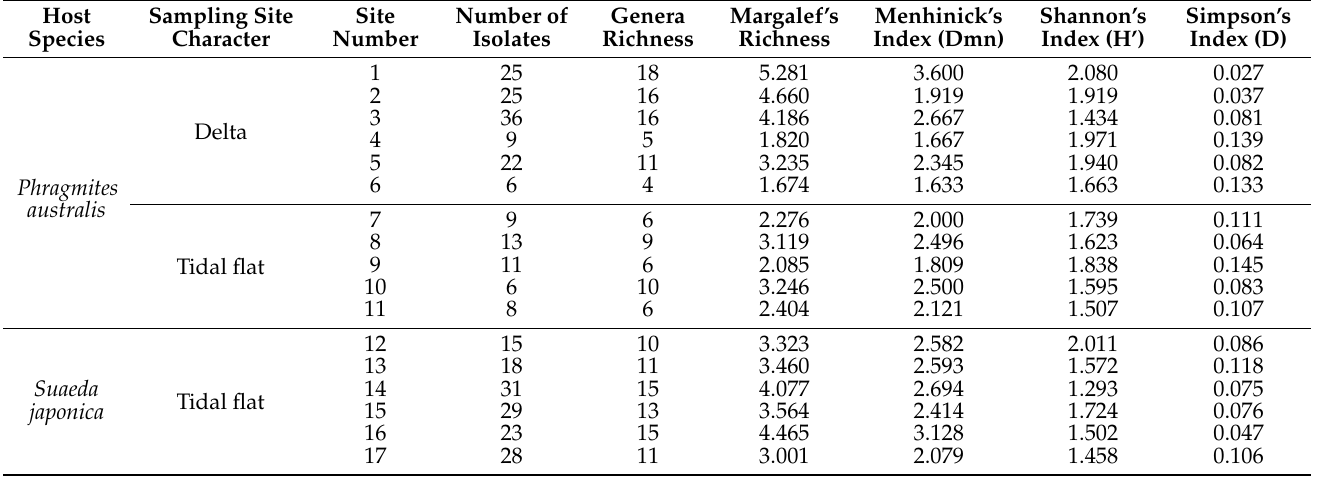
Table 2. Diversity of the endophytes from each dominant species flourishing at sampling each